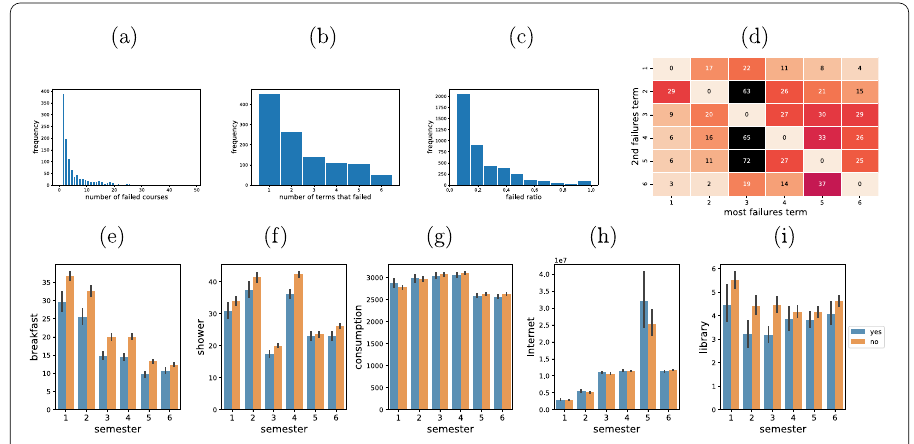
labeled by ‘no’ represent non-failed